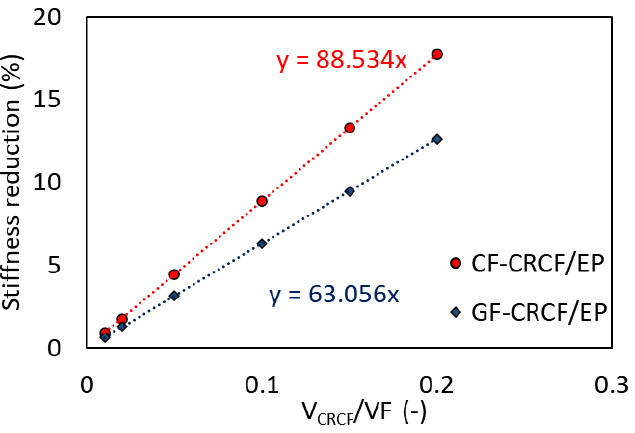
Figure 10. Reduction in stiffness of conventional composites by addition of coated cellulose tows as estimated by the rule of mixtures. The equations on the figure correspond to the trendlines of the data points, where x is the slope of the